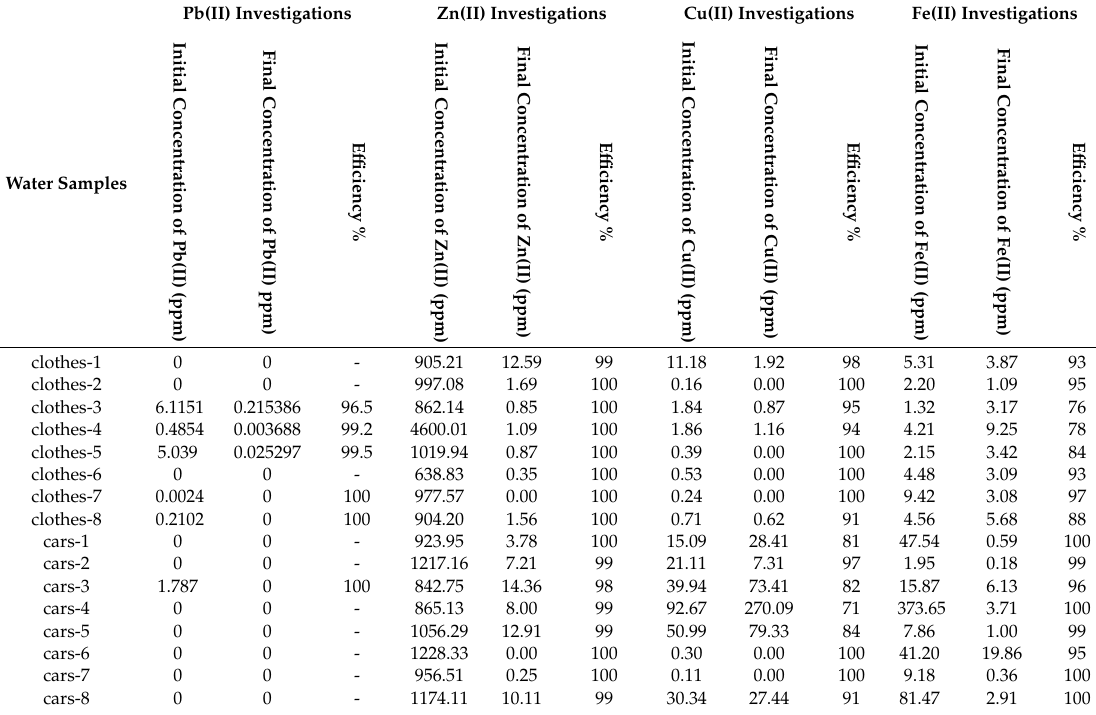
Table 4. E ffi ciency of the removal of Pb(II), Zn(II), Cu(II), and Fe(II) from water samples from di ff erent clothes and car washing centers in Riyadh